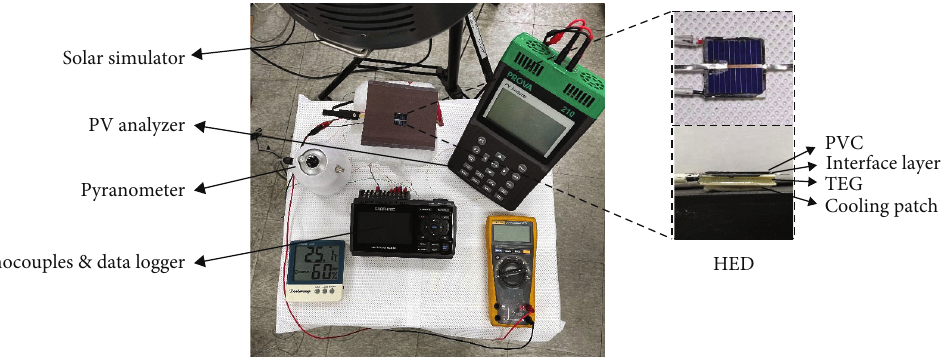
Figure 2: Experimental set-up and the optical image of the